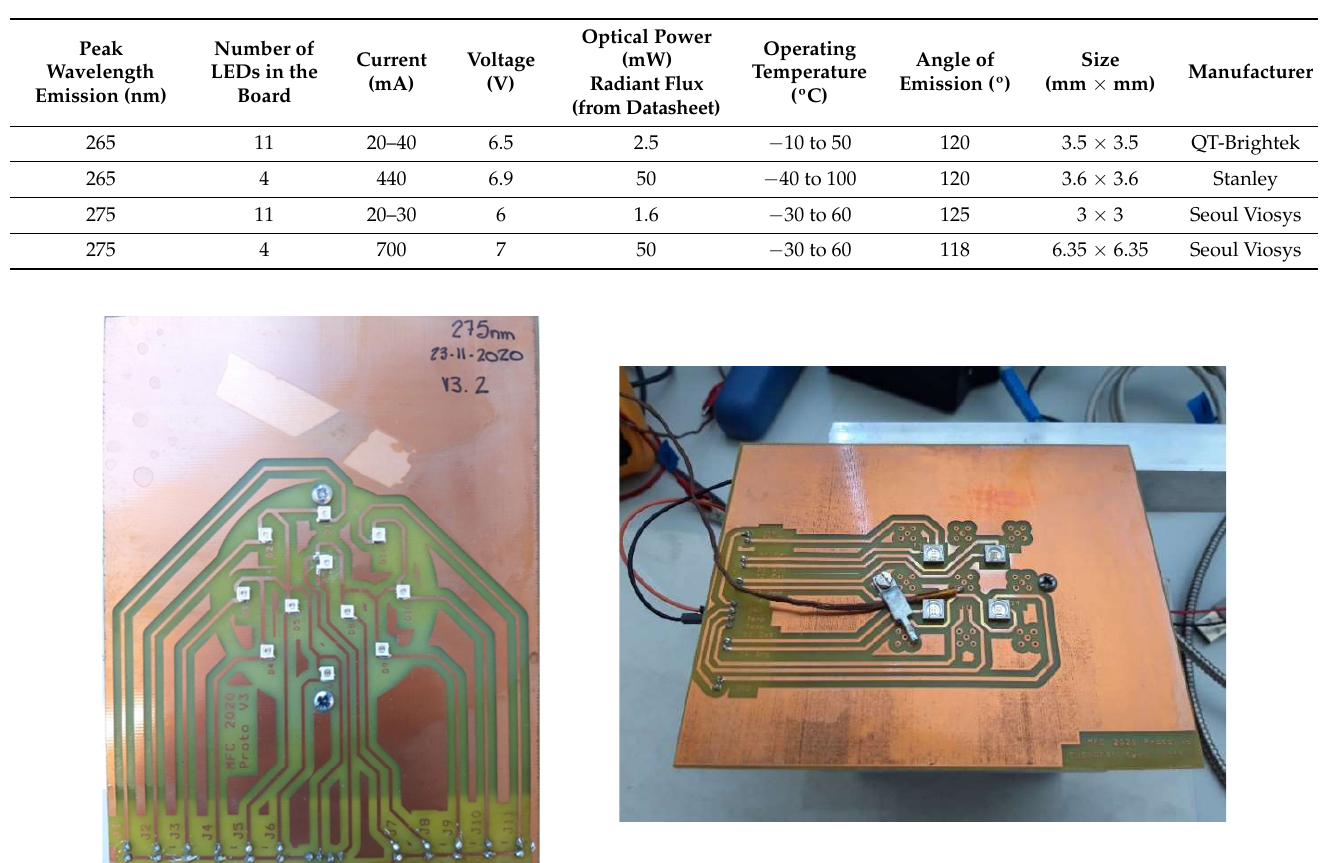
Table 1. UV-LEDs characteristics from manufacturers datasheet.